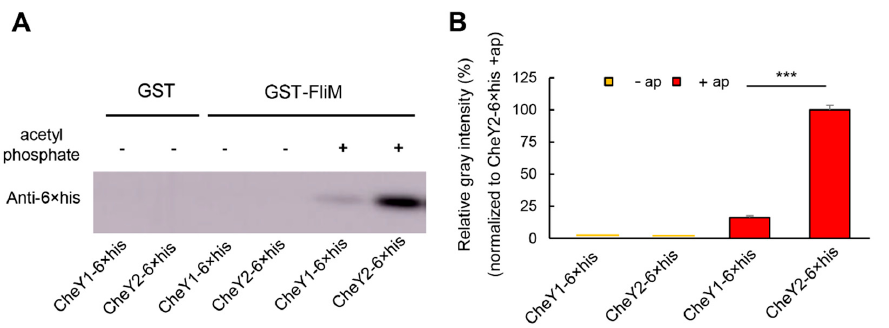
Figure 4. In vitro analysis of the interactions of two CheY proteins with FliM. Protein–protein interaction was tested by GST pull-down assay. The GST-FliM fusion protein was used to pull-down CheY1-6 × his or CheY2-6 × his fusion proteins. GST was used as the control. The pulled-down proteins were analyzed by Western blot using the anti-6 × his tag antibody. ( A ) Western blot test of CheY1-6 × his and CheY2-6 × his pulled-down by GST or GST-FliM in the absence ( − ) or presence (+) of acetyl phosphate. ( B ) Relative gray intensities of the Western blot bands of CheY1-6 × his and CheY2-6 × his pulled-down by GST-FliM in the absence ( − ap) or presence (+ap) of acetyl phosphate. The line in ( B ) represents the value close to zero. Data are the means of three biological replicates with the standard deviations. The bars connected by “***” mark mean that they are different in a statistically significant manner at p < 0.001 via unpaired Student’s t test.